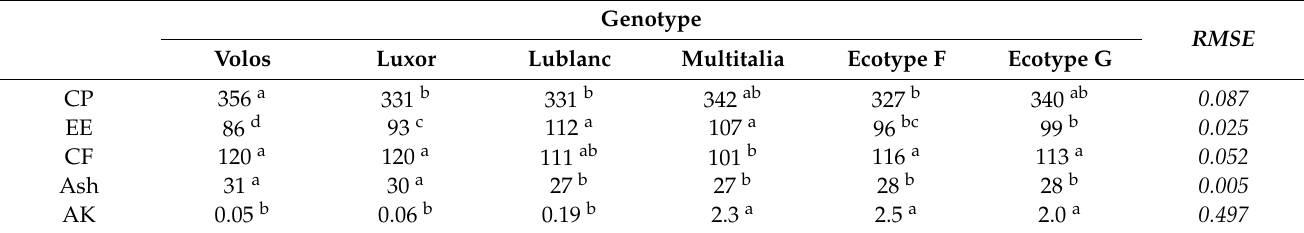
Table 2. Chemical composition (g kg − 1 , as fed) of the six genotypes of Lupinus albus L. (n = 18).